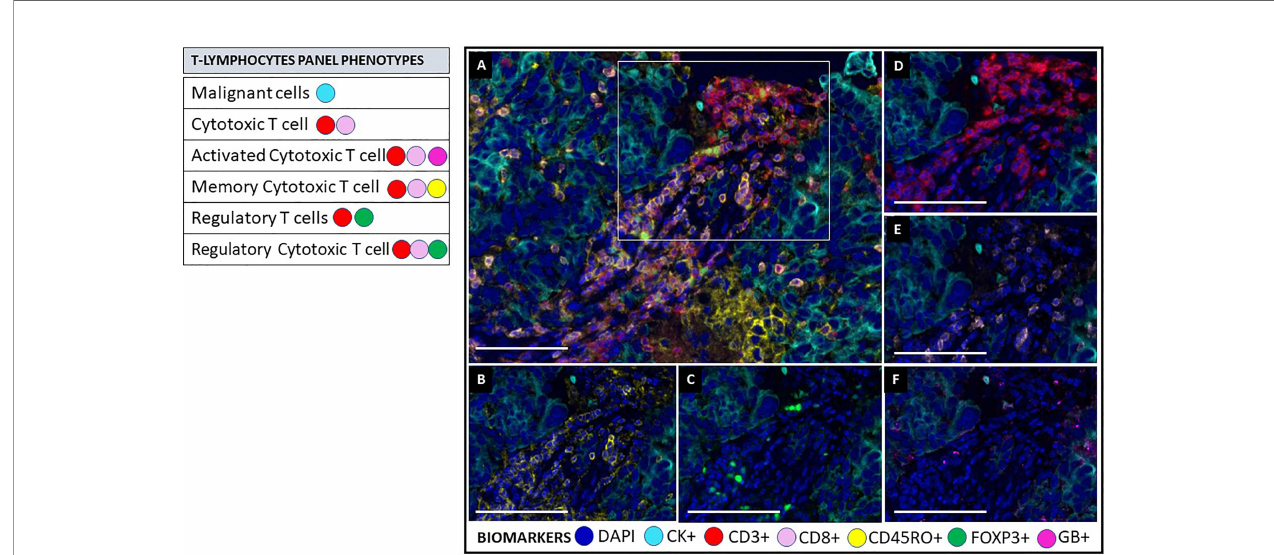
FIGURE 5 | Multiplex immuno fl uorescence T lymphocytes panel. As on the activation panel, the T lymphocytes panel includes a universal biomarker for nuclear detection (DAPI) and cytokeratin for detection of epithelial cells (malignant cells), which is also helpful for compartmentalization of the image (tumor vs. stroma). T lymphocyte populations are detected using CD3+ for all lymphocytes, co-expressed CD8+ for cytotoxic T cells, and co-expressed FOXP3+ for regulatory T-cells. This panel includes granzyme B+ (GB) and CD45RO+ to identify activated T-cells and memory T-cells, respectively. (A) Composite image of TME from oral squamous cell carcinoma, showing all markers of a multiplex immuno fl uorescence “ T lymphocytes phenotypes ” , activated simultaneously. (B) Composite image showing CD45RO positive expression (yellow) of immune cells in the stromal compartment. (C) Composite image showing FOXP3 positive expression (green) of immune cells in the stromal compartment. (D) Composite image showing CD3 positive expression (red) of immune cells in the stromal compartment. (E) Composite image showing CD8 positive expression (pink) of immune cells in the stromal compartment. (F) Composite image showing GB positive expression (magenta) of immune cells in the stromal compartment. inForm ® image analysis software, Akoya bioscience (scale bar: 100 m m). Scanner Vectra Polaris. DAPI (blue-DAPI), cytokeratin (cyan-opal 620), CD3+ (red-opal 690), CD8+ (pink-opal 540), CD45RO+ (yellow-opal 520), FOXP3+ (green-opal 650), Granzyme B+ (magenta-opal